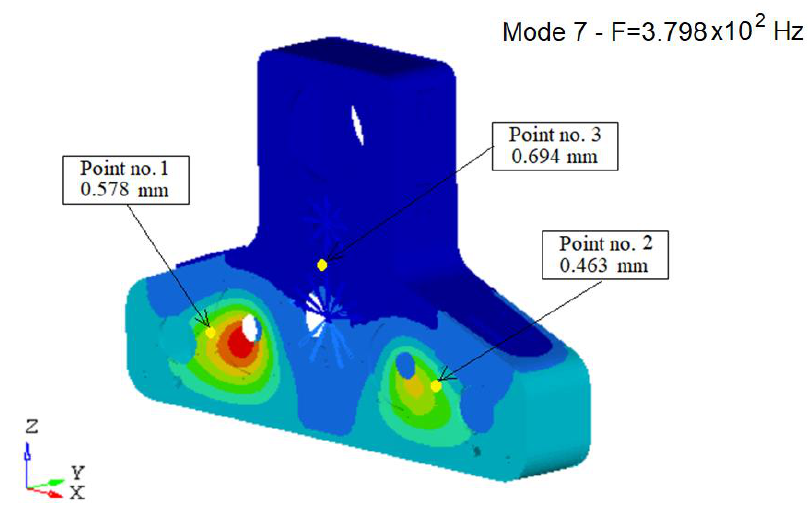
Figure 12. Displacements at the points on the front surface of the housing for mode 7.